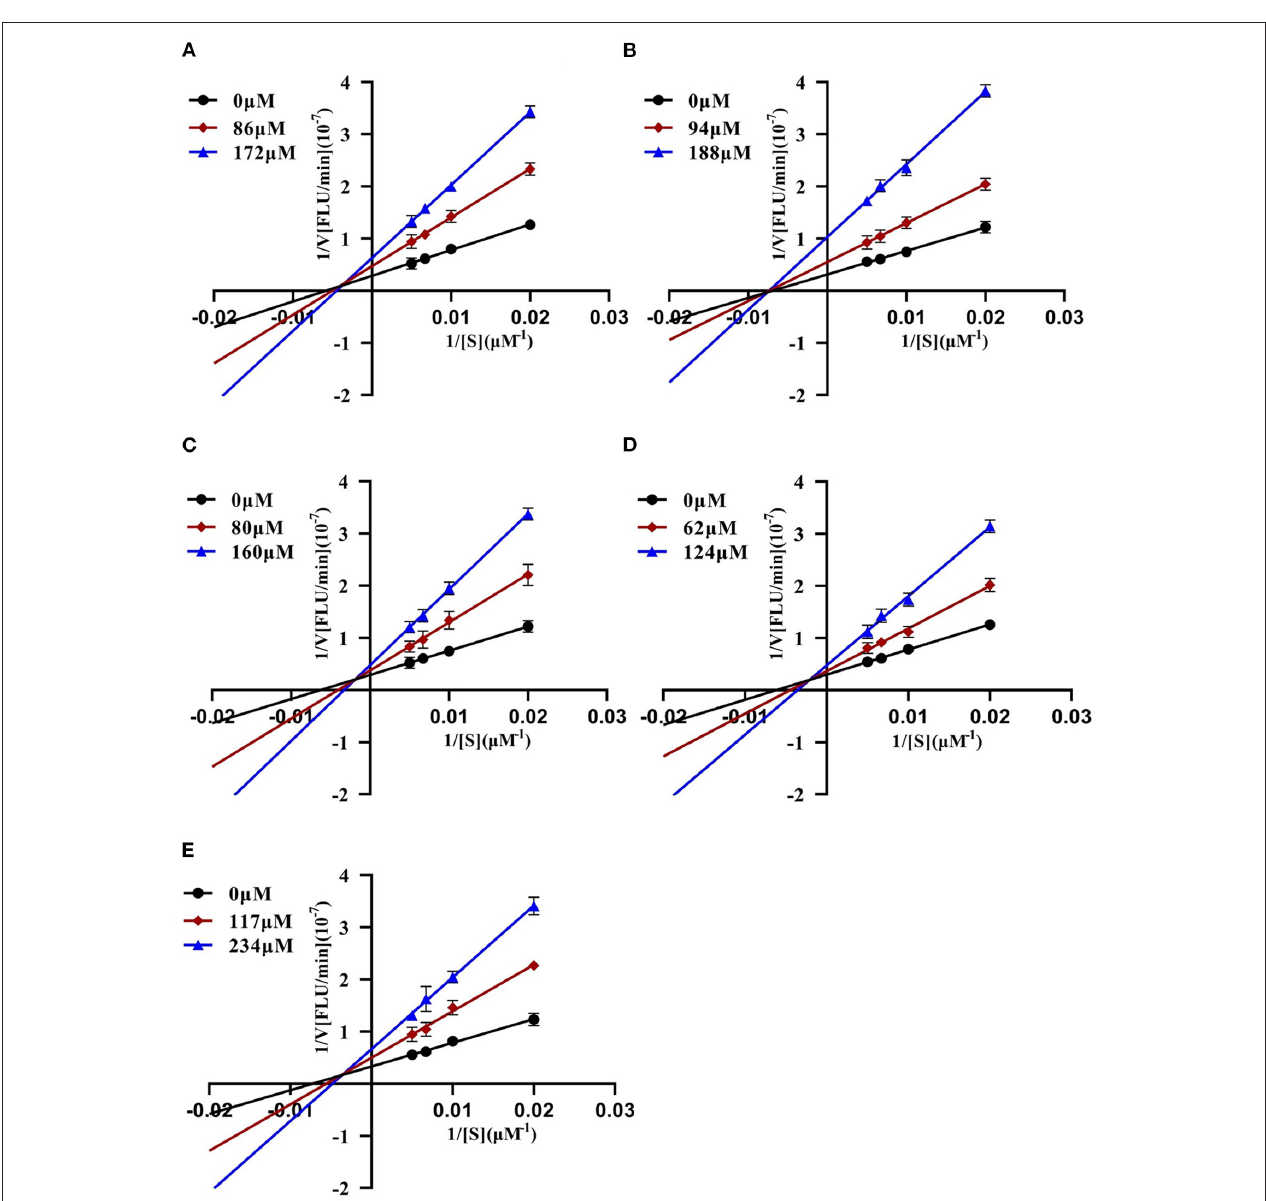
FIGURE 2 | Lineweaver-Burk plots of DPP-4 inhibition by hyperoside (A) , myricetin (B) , narcissoside (C) , cyanidin 3-O-glucoside (D) , isoliquiritigenin (E) .